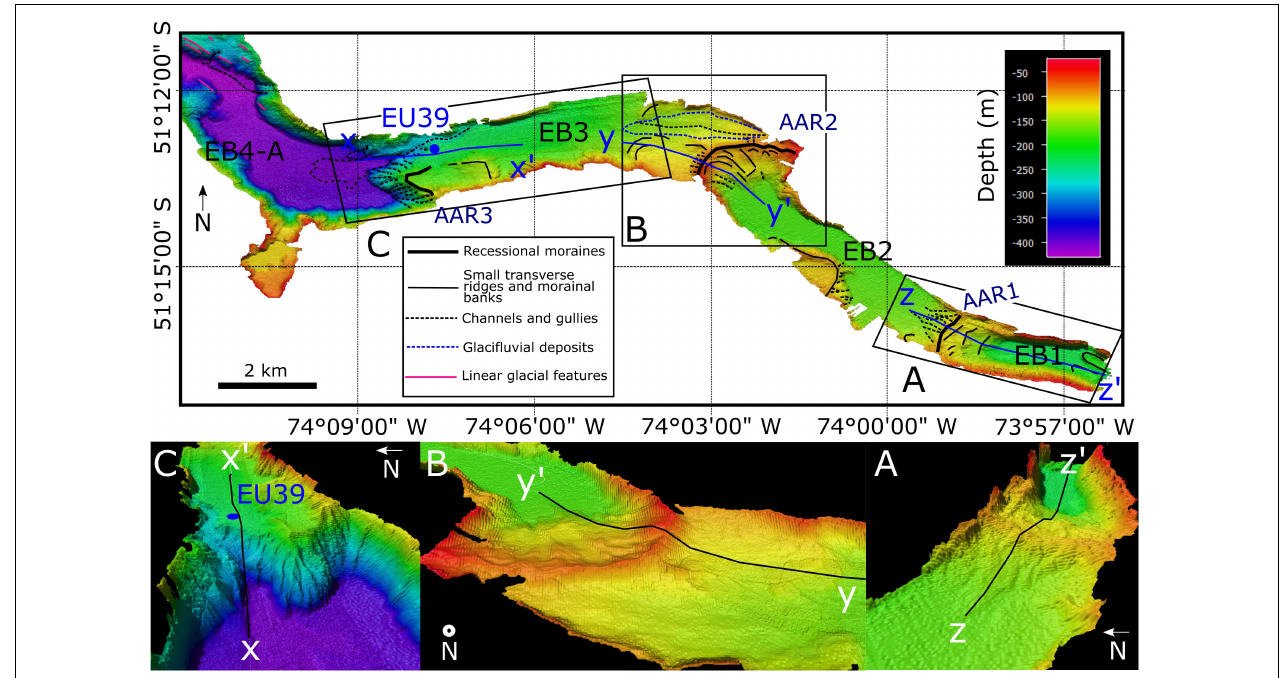
FIGURE 3 | Submarine geomorphology of the inner fjord area from multibeam bathymetry from Cruise CIMAR 23 and SHOA data. Interpretation of landforms are showed. Codes: EB, Europa Basin; AAR, Arcuate Asymmetrical Ridge. (A) Moraine proximal subarea and 3D model showing the SBP track for Figure 6 . (B) Moraine medial subarea and 3D model showing the SBP track for Figure 6 . (C) Moraine distal subarea and 3D model showing the SBP track for Figure 6 , and location of the EU39 sediment core.